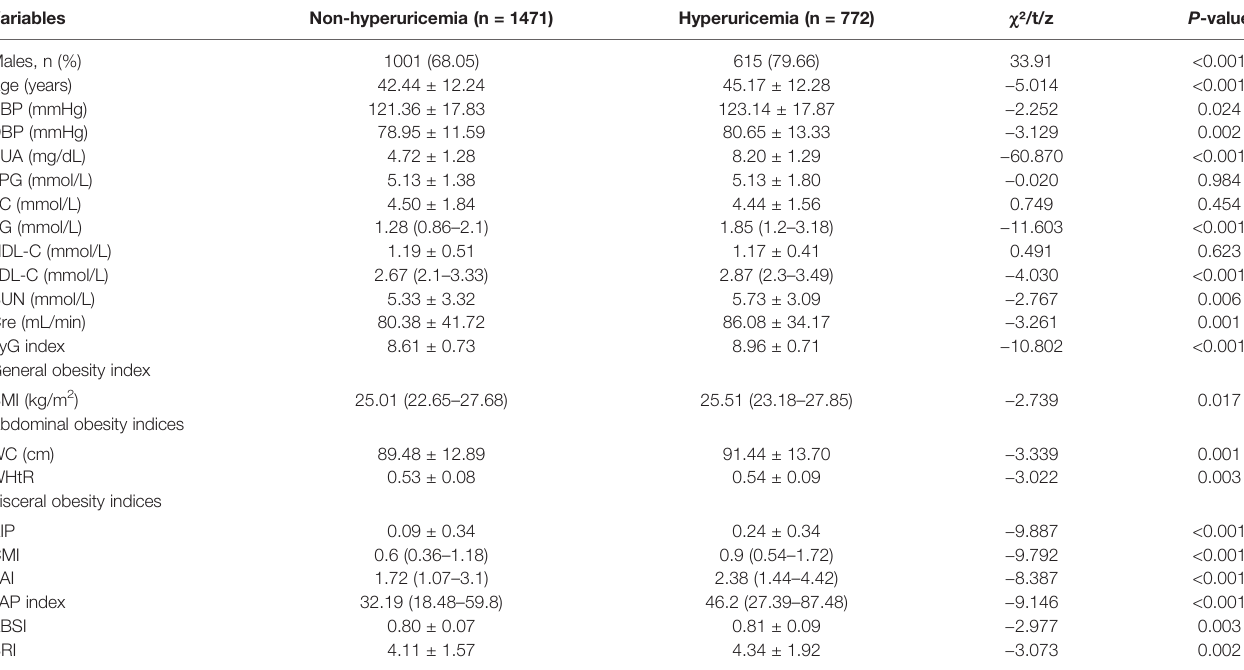
TABLE 1 | Clinical characteristics of study participants with and without hyperuricemia.